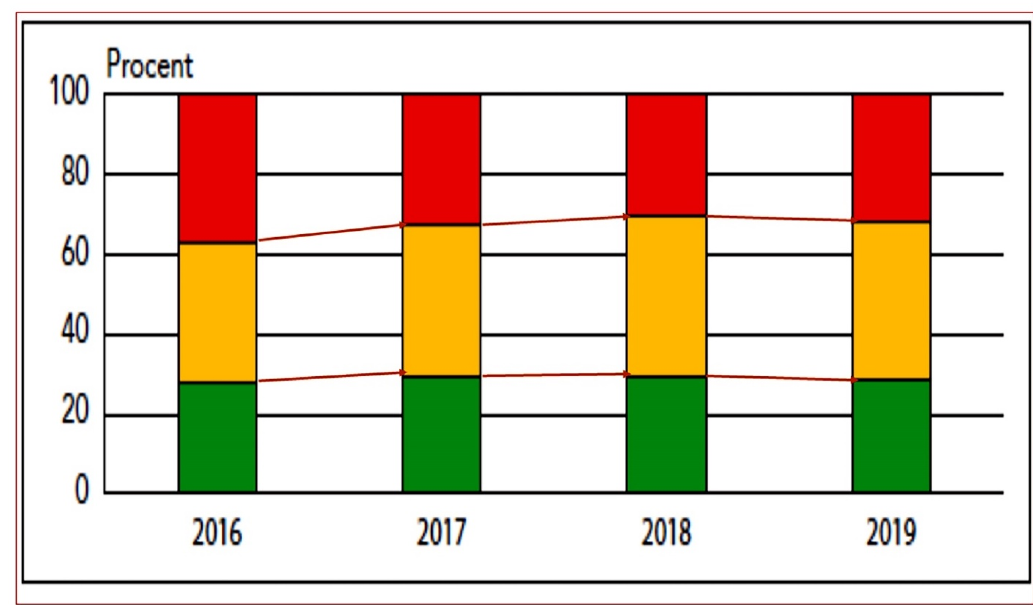
Figure 4. Summarized results for all participating municipalities in sustainability index 2016–2019 [7].